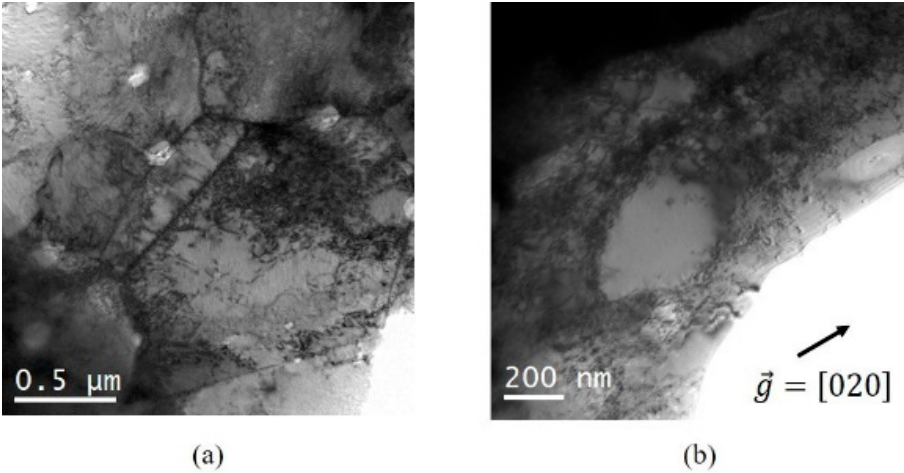
Figure 12. TEM images of sample 1 (d = 0.82 µm) deformed up to fracture. Grains with different contrasts possibly due to a high density of dislocations ( a ) and a nanometric dislocation cell ( 𝑔⃗ = (cid:4670)020(cid:4671)) ( b ).